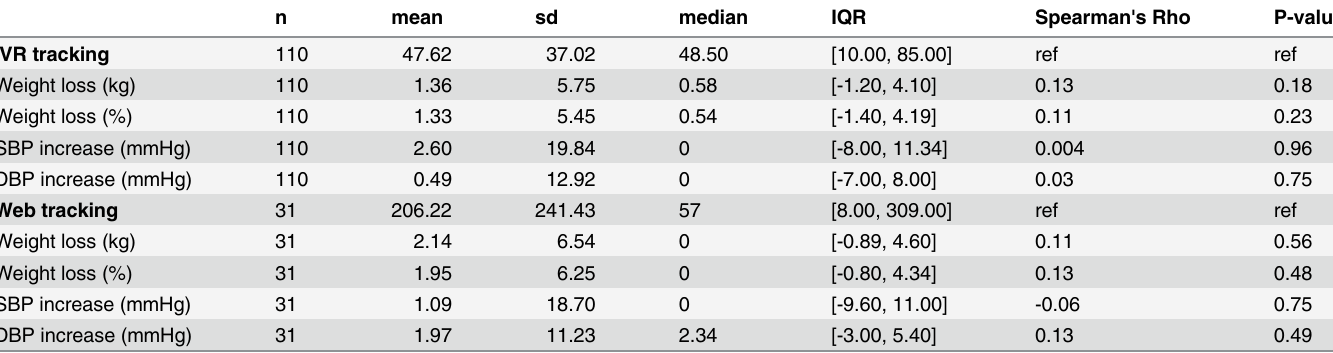
Table 4. Correlations between self-monitoring and weight and blood pressure